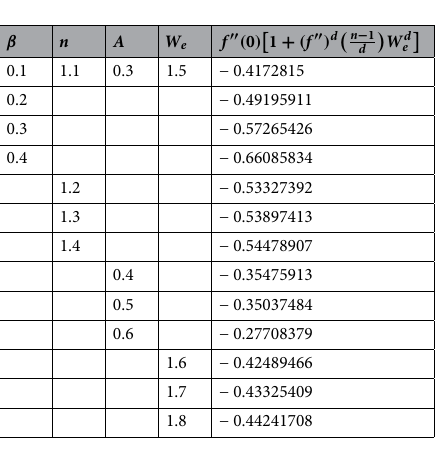
Table 1. Numerical estimation of C f